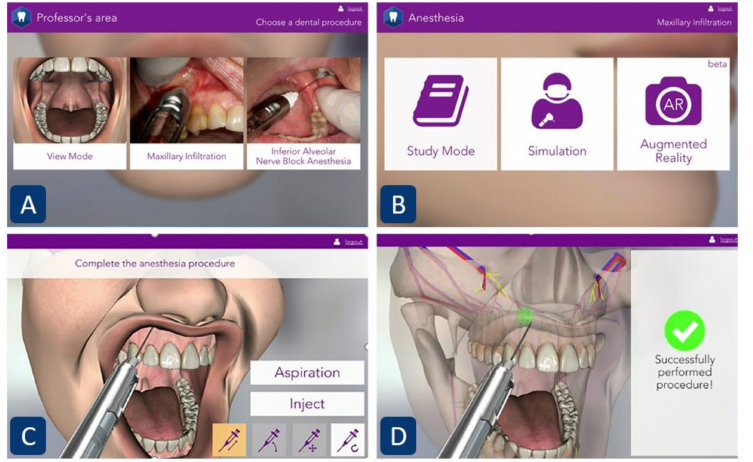
Figure 1. The Dental Simulator mobile application. ( A ) Demonstration of various LA administration techniques offered by the application. ( B ) Various modes of the application. ( C ) Demonstrating the syringe control buttons that allow the syringe to rotate, move, reset and inject. ( D ) The demonstration of correct technique for the maxillary infiltration